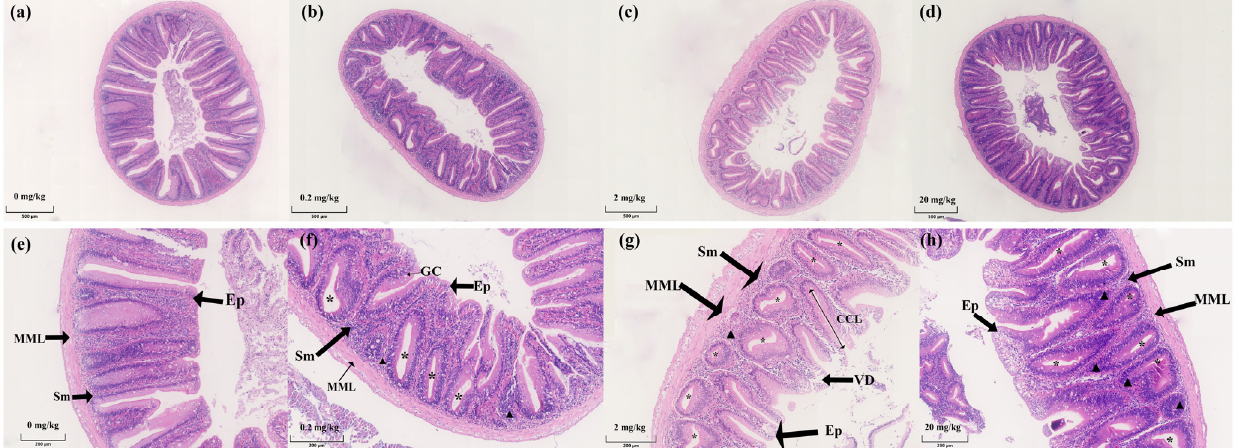
Figure 1. Transverse sections of the intestinal tract of carp chronically fed test diets containing KM: ( a ) 0 mg/kg group; ( b ) 0.2 mg/kg group; ( c ) 2 mg/kg group; ( d ) 20 mg/kg group (hematoxylin and eosin, HE, 5×); ( e ) 0 mg/kg group; ( f ) 0.2 mg/kg group; ( g ) 2 mg/kg group; ( h ) 20 mg/kg group (HE, 20×). Ep: epithelium, MML: muscular mucosa layer, Sm: submucosa, GC: goblet cells, triangular arrows: cell proliferation and disorder of arrangement, Asterisks: crypt cells.